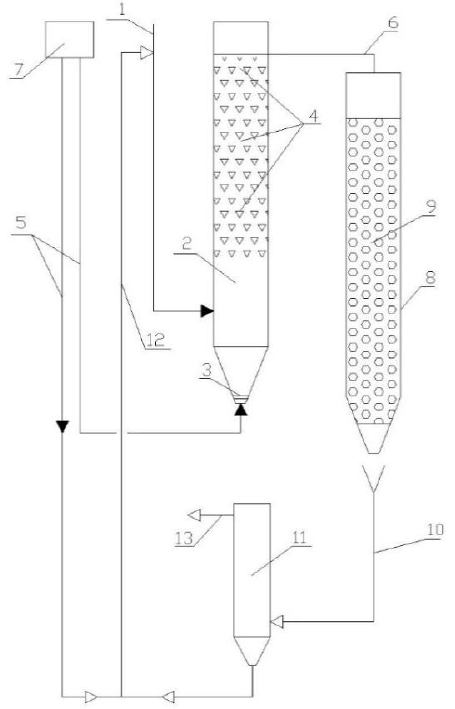
Figure 7. Scheme of the lab-scale bench: 1 — wastewater influent; 2 — ASR; 3 — aeration device; 4 — floating carrier; 5 — air supply; 6 — effluent from ASR to TF; 7 — compressor; 8 — TF; 9 — biomass carrier in TF; 10 — discharge of treated wastewater for clarification; 11 — SC; 12 — RAS; 13 — effluent.